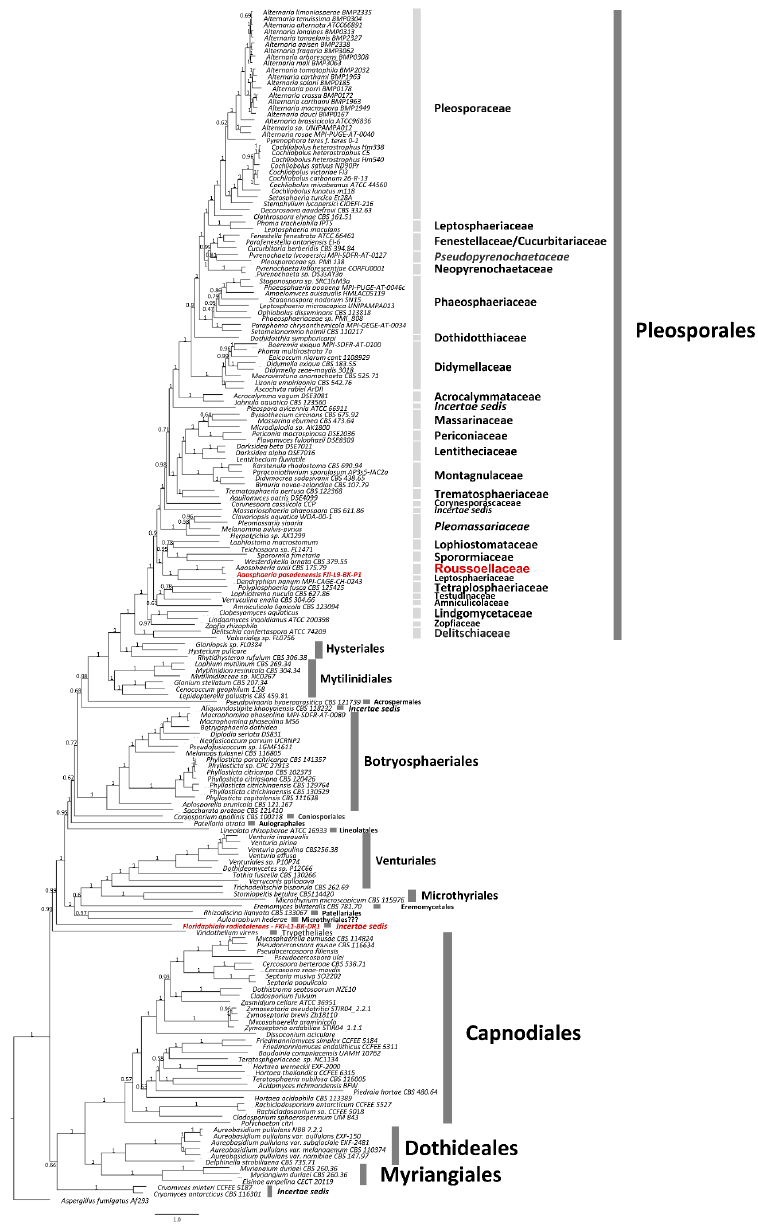
Figure 3. The WGS-based phylogenomic analysis for A. pasadenensis and F. radiotolerans . A phy- logenomic tree was constructed for two strains A. pasadenensis and F. radiotolerans . ML tree was constructed using the RAxML and ASTRAL software. Aspergillus fumigatus Af293 was set as the out- group and the branches are proportional to the number of mutations. Branch fidelity used posterior probabilities, which were added next to the corresponding